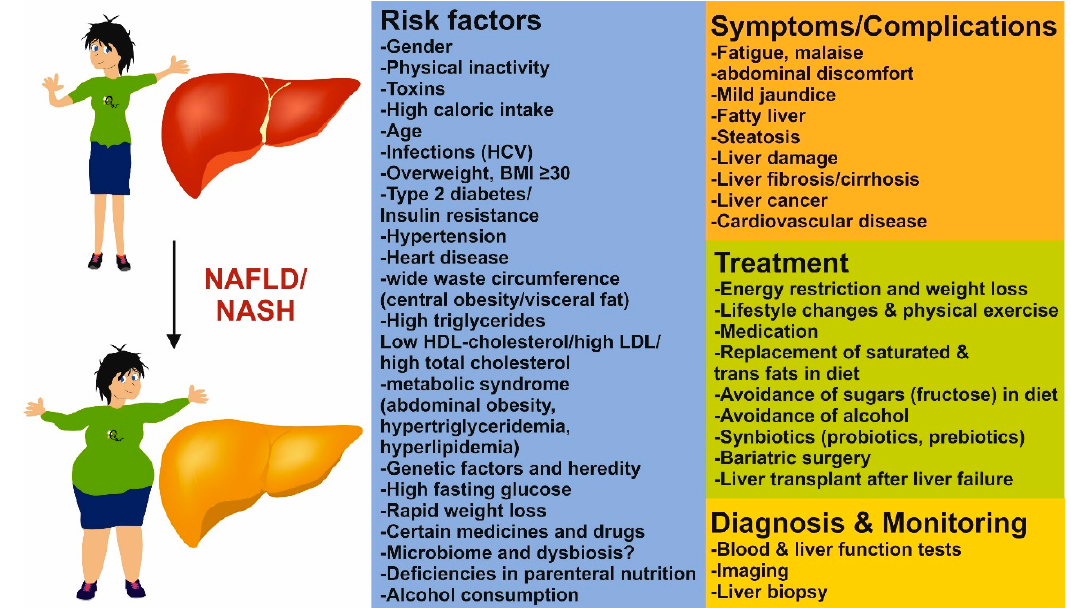
Figure 1. Risk factors, symptoms, diagnosis, and treatment of nonalcoholic liver disease. Predisposition and disease progression in NAFLD/NASH is influenced by comorbidities [6], genetic determinants [7], and environmental factors including drugs and toxins [8]. The range of resulting symptoms and complication of NAFLD/NASH can vary from very mild to life-threating. Diagnosis and monitoring of disease can be done by blood tests [9], liver function tests [10] and imaging [11]. However, a liver biopsy should be performed based on an individualized decision and is still the gold standard in scoring and grading of steatosis, inflammation, and fibrosis [12]. Although an ultimate therapy is still missing, beneficial effects on NAFLD/NASH progression are energy restriction, lifestyle changes, improved diets, and elevated physical activity [13]. In addition, in biopsy-proven NASH and fibrosis, medication with antiglycemic drugs, insulin sensitizers, synbiotics, or compounds interfering with fat metabolism or preventing oxidative stress have favorable effects on disease outcome [13,14]. Surgical procedures, including bariatric surgery, to treat obesity and liver transplant after liver failure are extreme forms in NAFLD/NASH treatment [15].